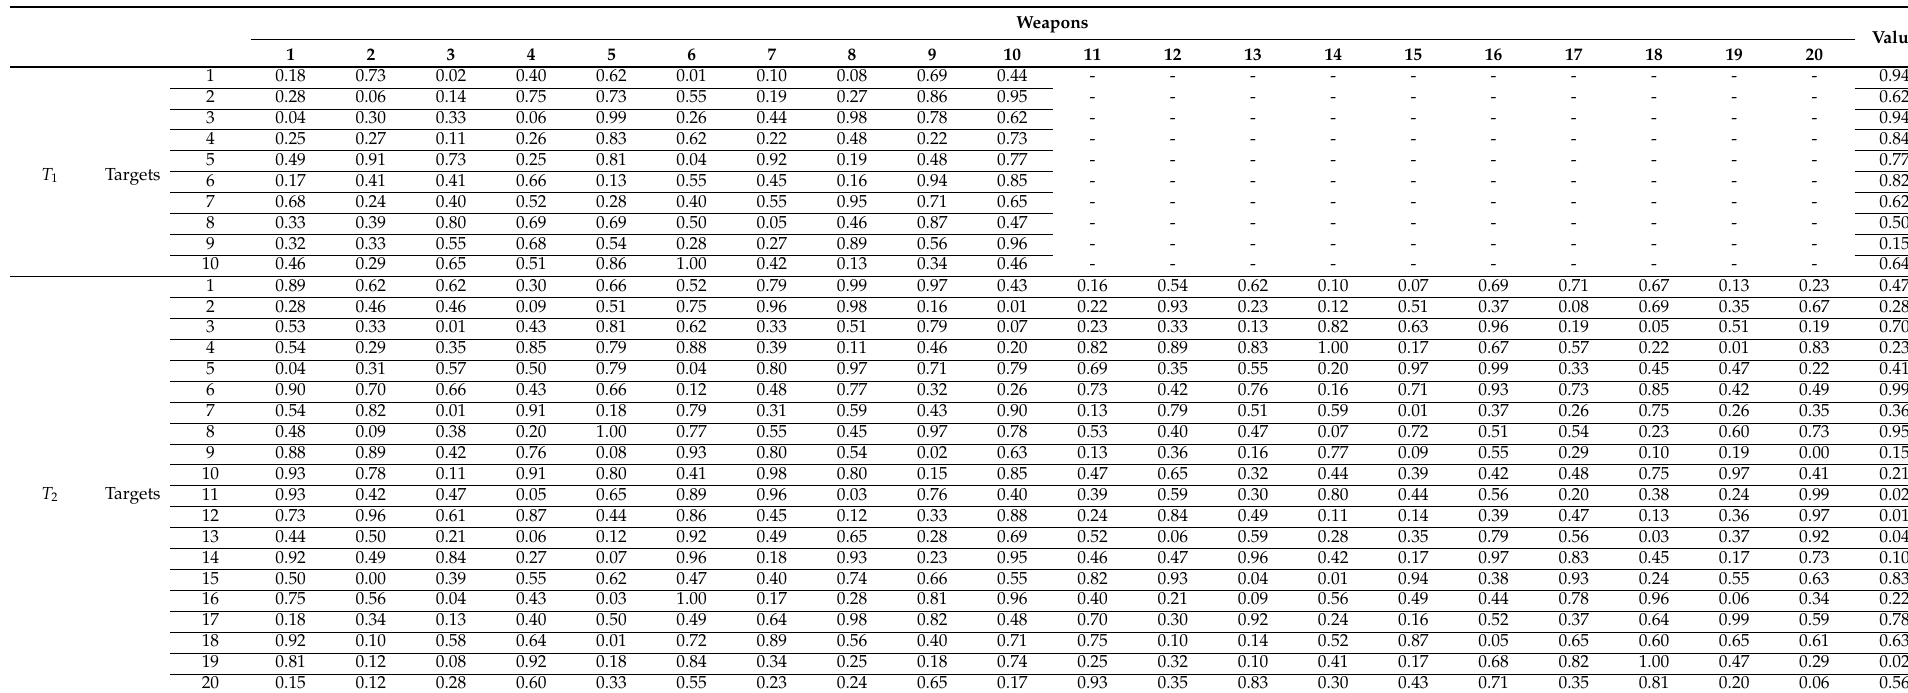
Table A6. Details of the destructive value of every target and the probability of kill for every weapon in the two component tasks of problem 6 in Table 2. Each task is a WTA